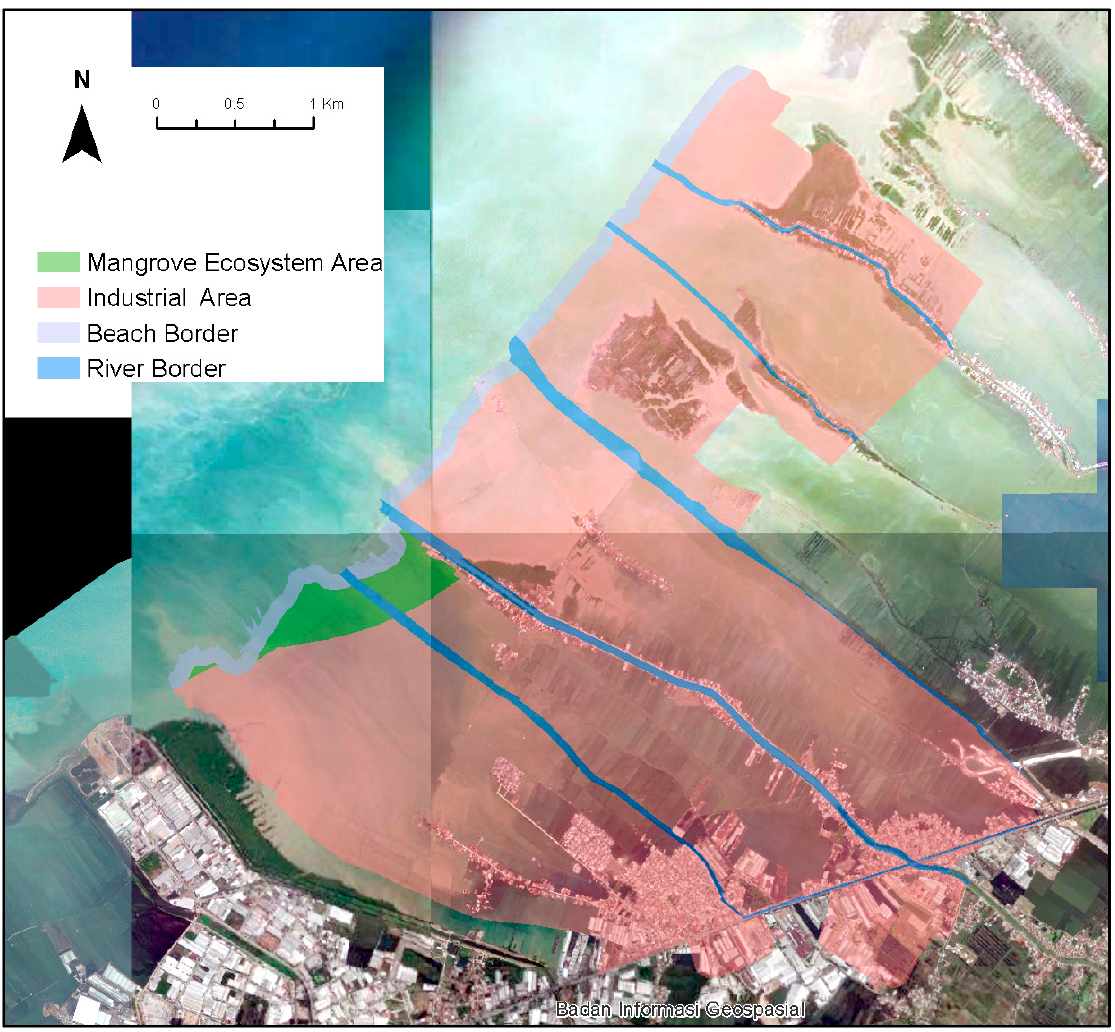
Figure 10. Second version of spatial planning in the study area in the period of 2011–2031 (after revision). In this version, almost all area is designated as industrial area, leaving only small portion for mangrove ecosystem area and beach border.